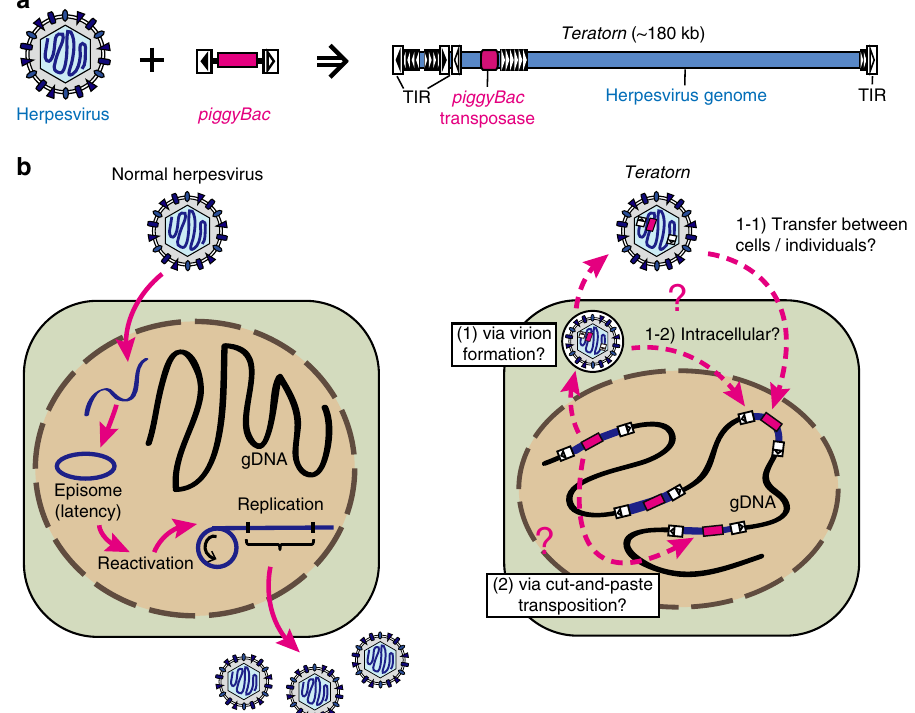
Fig. 6 Model of Teratorn derivation from a herpesvirus that shifted to an intragenomic life cycle by gaining the piggyBac transposon system. a The entire structure of Teratorn . Teratorn is a fusion of a piggyBac -like transposon and a herpesvirus. b Comparison of life cycles of normal herpesviruses and Teratorn . Normal herpesviruses do not integrate their genome into chromosomes of host cells during their life cycles; instead, they form episomal DNA molecules and persist inside cells, accompanied by recursive reactivation ( left ). Teratorn might be derived from a herpesvirus that had shifted its life cycle to an intragenomic transposon-like parasite, by gaining the piggyBac transposon system. The transposition mechanism might be either via (1) DNA replication and virus particle formation or (2) conventional cut-and-paste transposition. Virus particles might be either (1 – 1) infectious and transmissible to other cells/individuals or (1 – 2) non-infectious and remain inside cells ( right